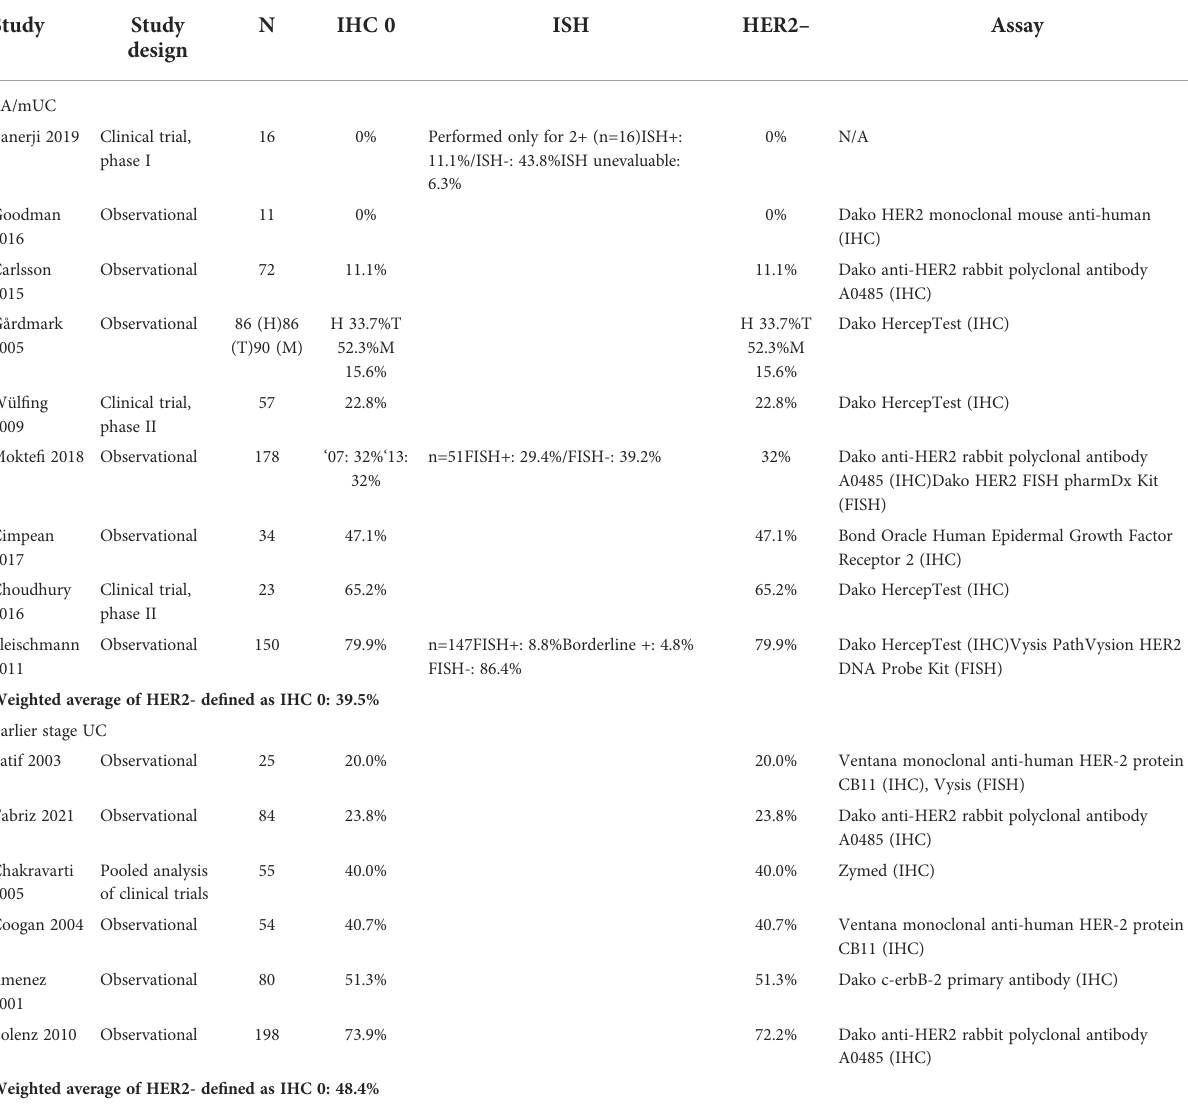
TABLE 3 Overview of